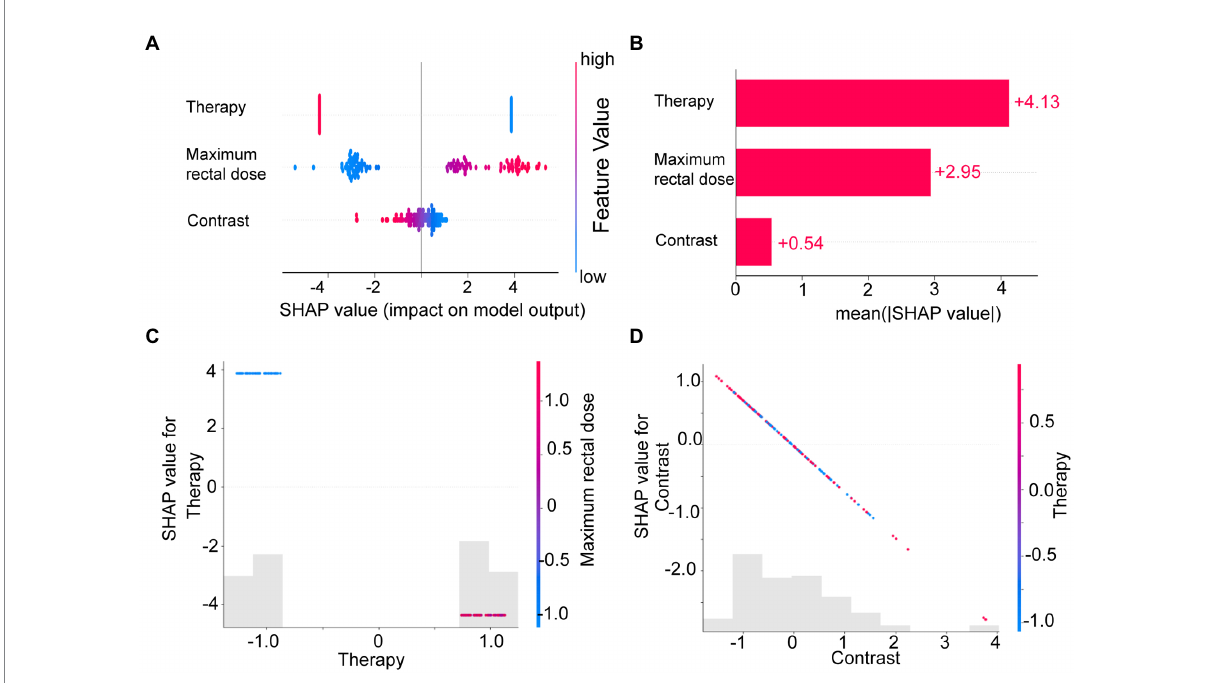
FIGURE 5 The SHAP plots illustrated the feature-based model interpretation process. (A) The beeswarm plot used SHAP values to show the distribution of each feature’s impacts. (B) The standard bar plot demonstrated the mean absolute value of the SHAP values for each feature. These two plots (C,D) showed the SHAP values in different features. Gray bar plots showed the SHAP values for each feature. Scatter plots showed the SHAP values of the other features most relevant to that feature. Vertical dispersion represented interaction effects between the horizontal and vertical